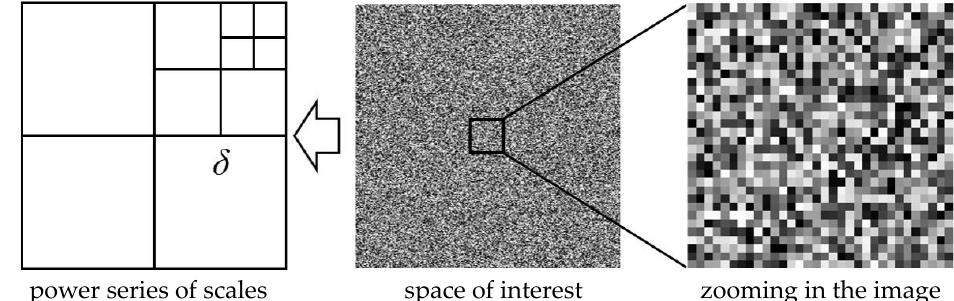
Figure 1. Schematic of meshing the space of interest in the multifractal analysis of a digital image.